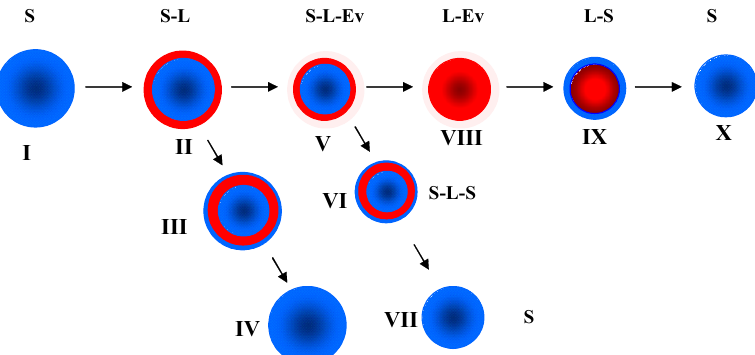
Figure 2. The phenomena occurring after injection of solid powder particle in plasma jet at APS [14]. The symbols described the phases in a particle: S, solid; L, liquid; and Ev, evaporated gas. Reproduced with permission from [Wiley Books], John Wiley and Sons, 2012.